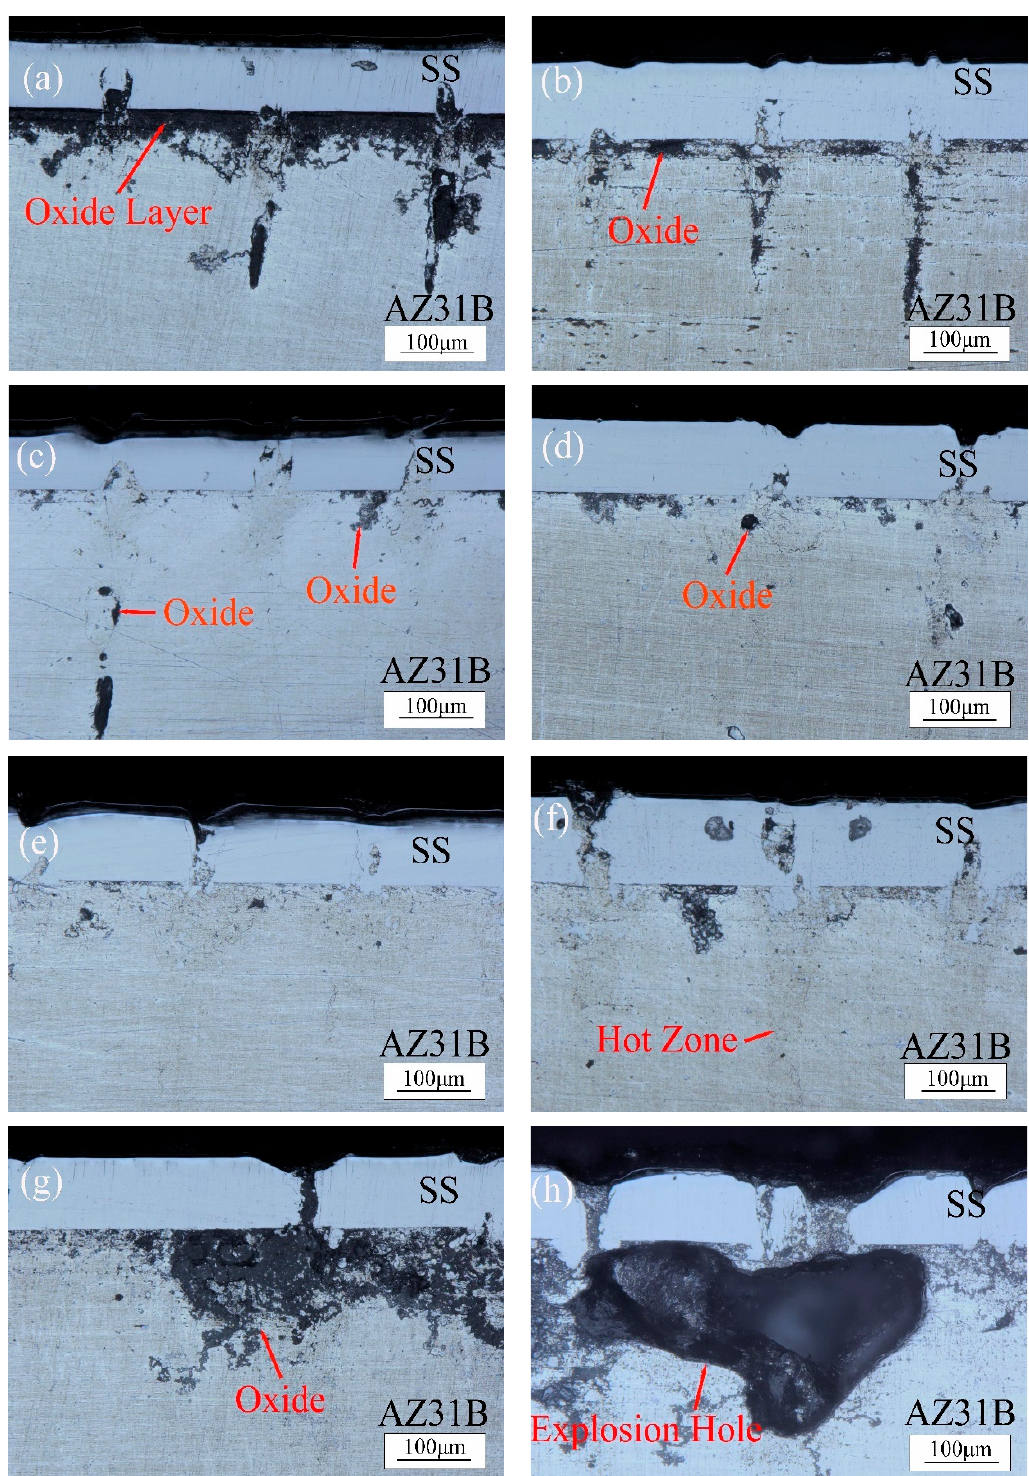
Figure 3. Cross section states of the weld seams at different powers ( a ) 15 W, ( b ) 20 W, ( c ) 25 W, ( d ) 30 W, ( e ) 35 W, ( f ) 40 W, ( g ) 45 W, ( h ) 50 W.